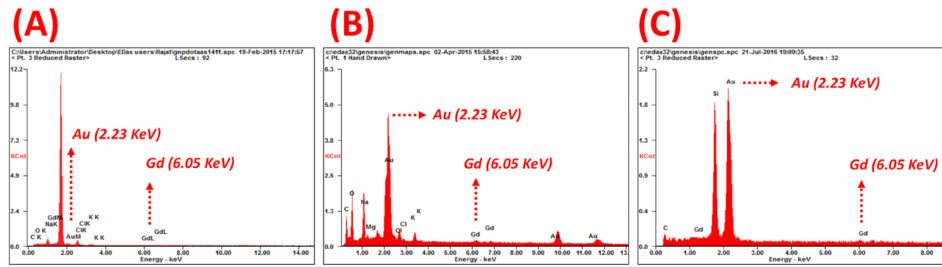
Figure 5. EDAX spectra of ( A ) GNP-Gd(III)-DO3A-SH-AS1411, ( B ) GNP-Gd(III)-DO3A-SH-CRO, and ( C ) GNP-Gd(III)-DO3A-SH-CTR collected with 20 KeV incident beam and displaying gold (2.23